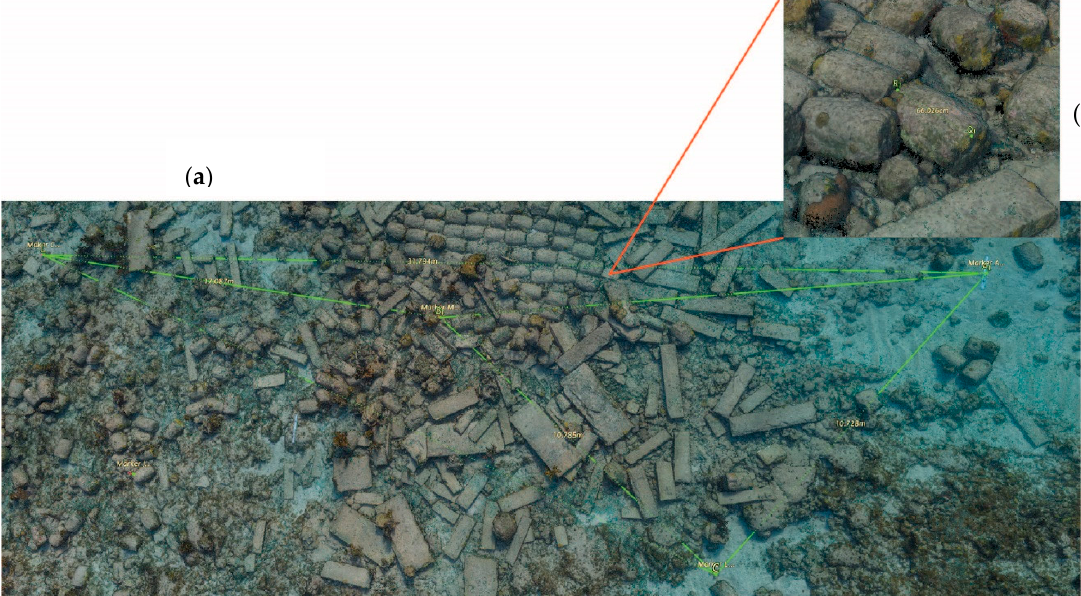
Figure 6. ( a ) Measurement of distances between markers in Viscore. ( b ) Blow-up of artifact measure.